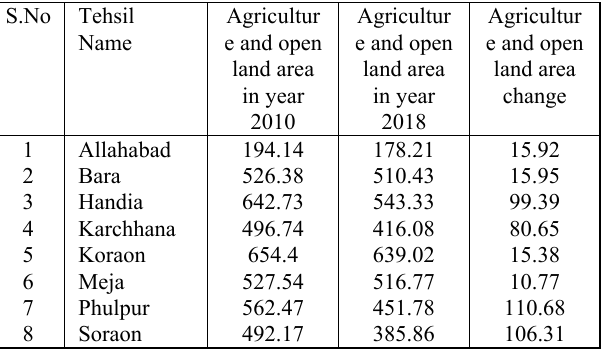
Table 4. Tehsil wise change in agriculture and open land